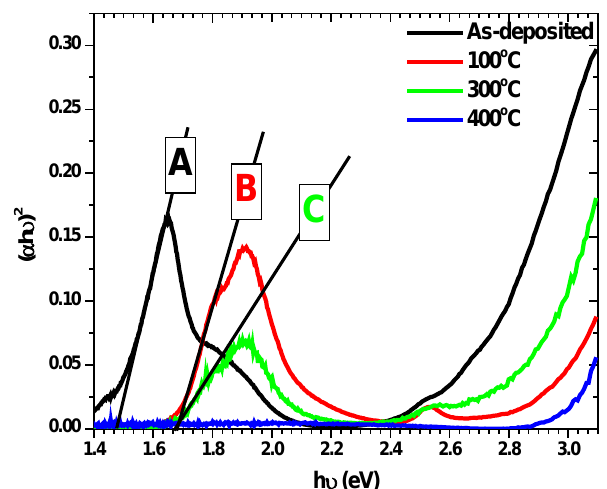
Figure 4. Plot of (αh ν ) 2 versus photon energy (h ν ) of FCrPc deposited and treated with different temperatures.